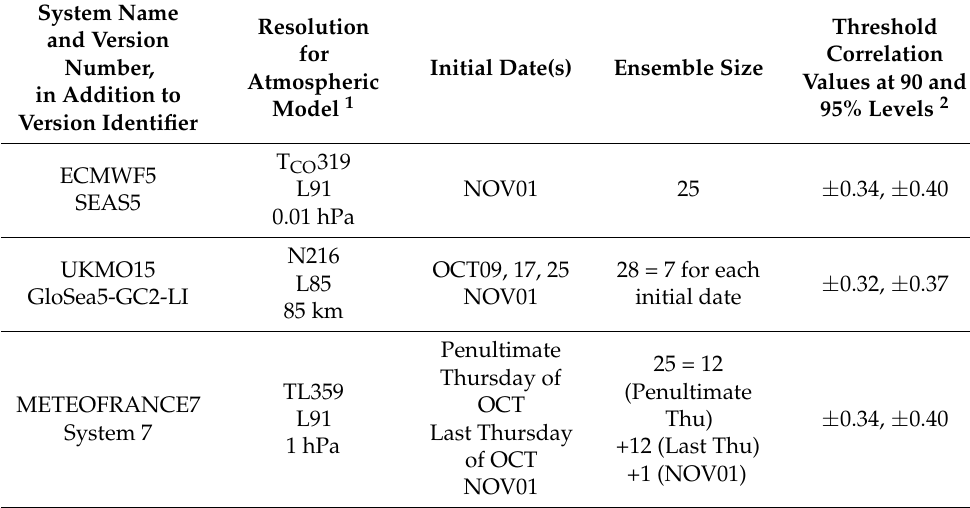
Table 1. Summary of the six forecast systems analyzed in this